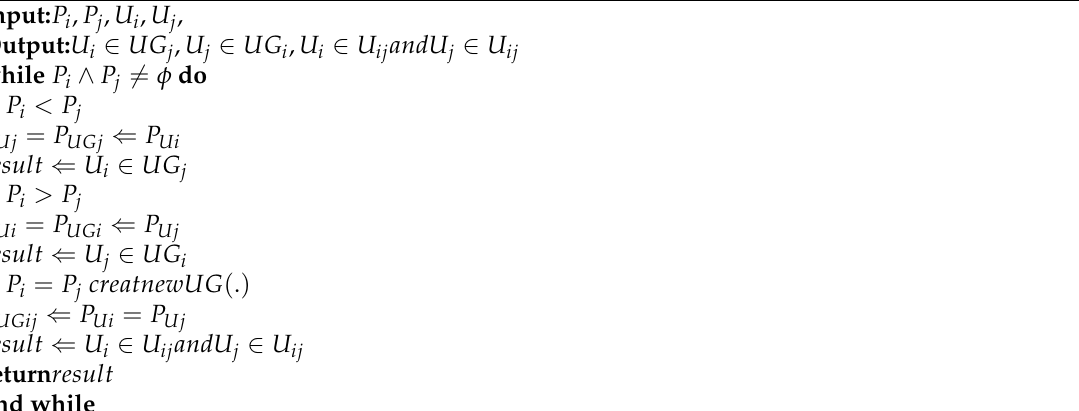
Algorithm 1 Groups users according to initial user login